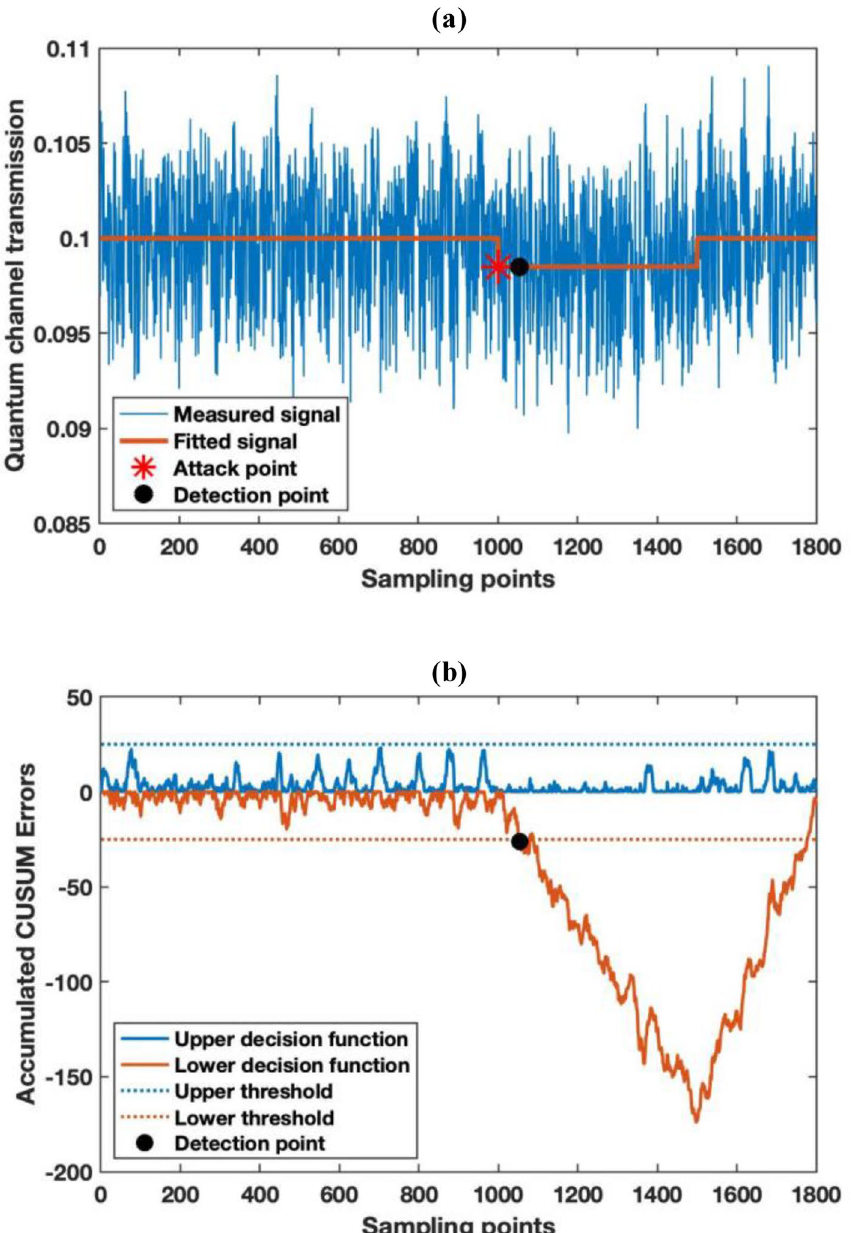
Figure 4. Monitoring result of channel loss under a fiber tapping attack and CUSUM analysis result. ( a ) The monitoring result of the quantum channel loss. ( b ) The accumulated CUSUM algorithm error for abrupt channel loss change